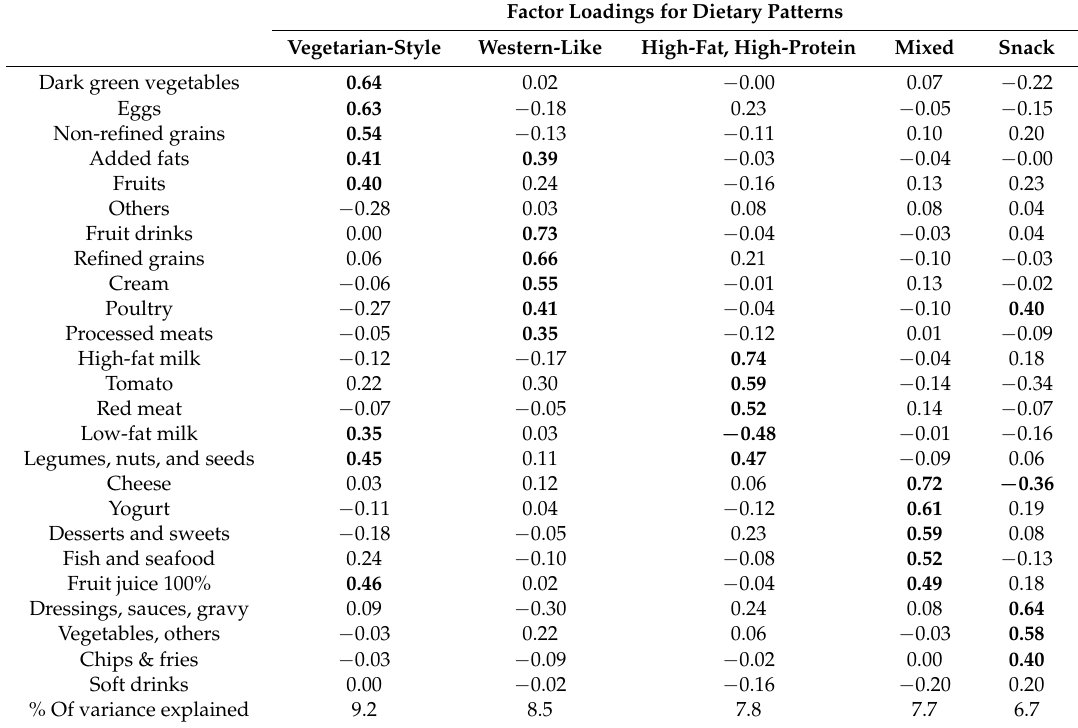
Table 2. Food groups included in principal component analysis and their factor loading for the identified five initial dietary